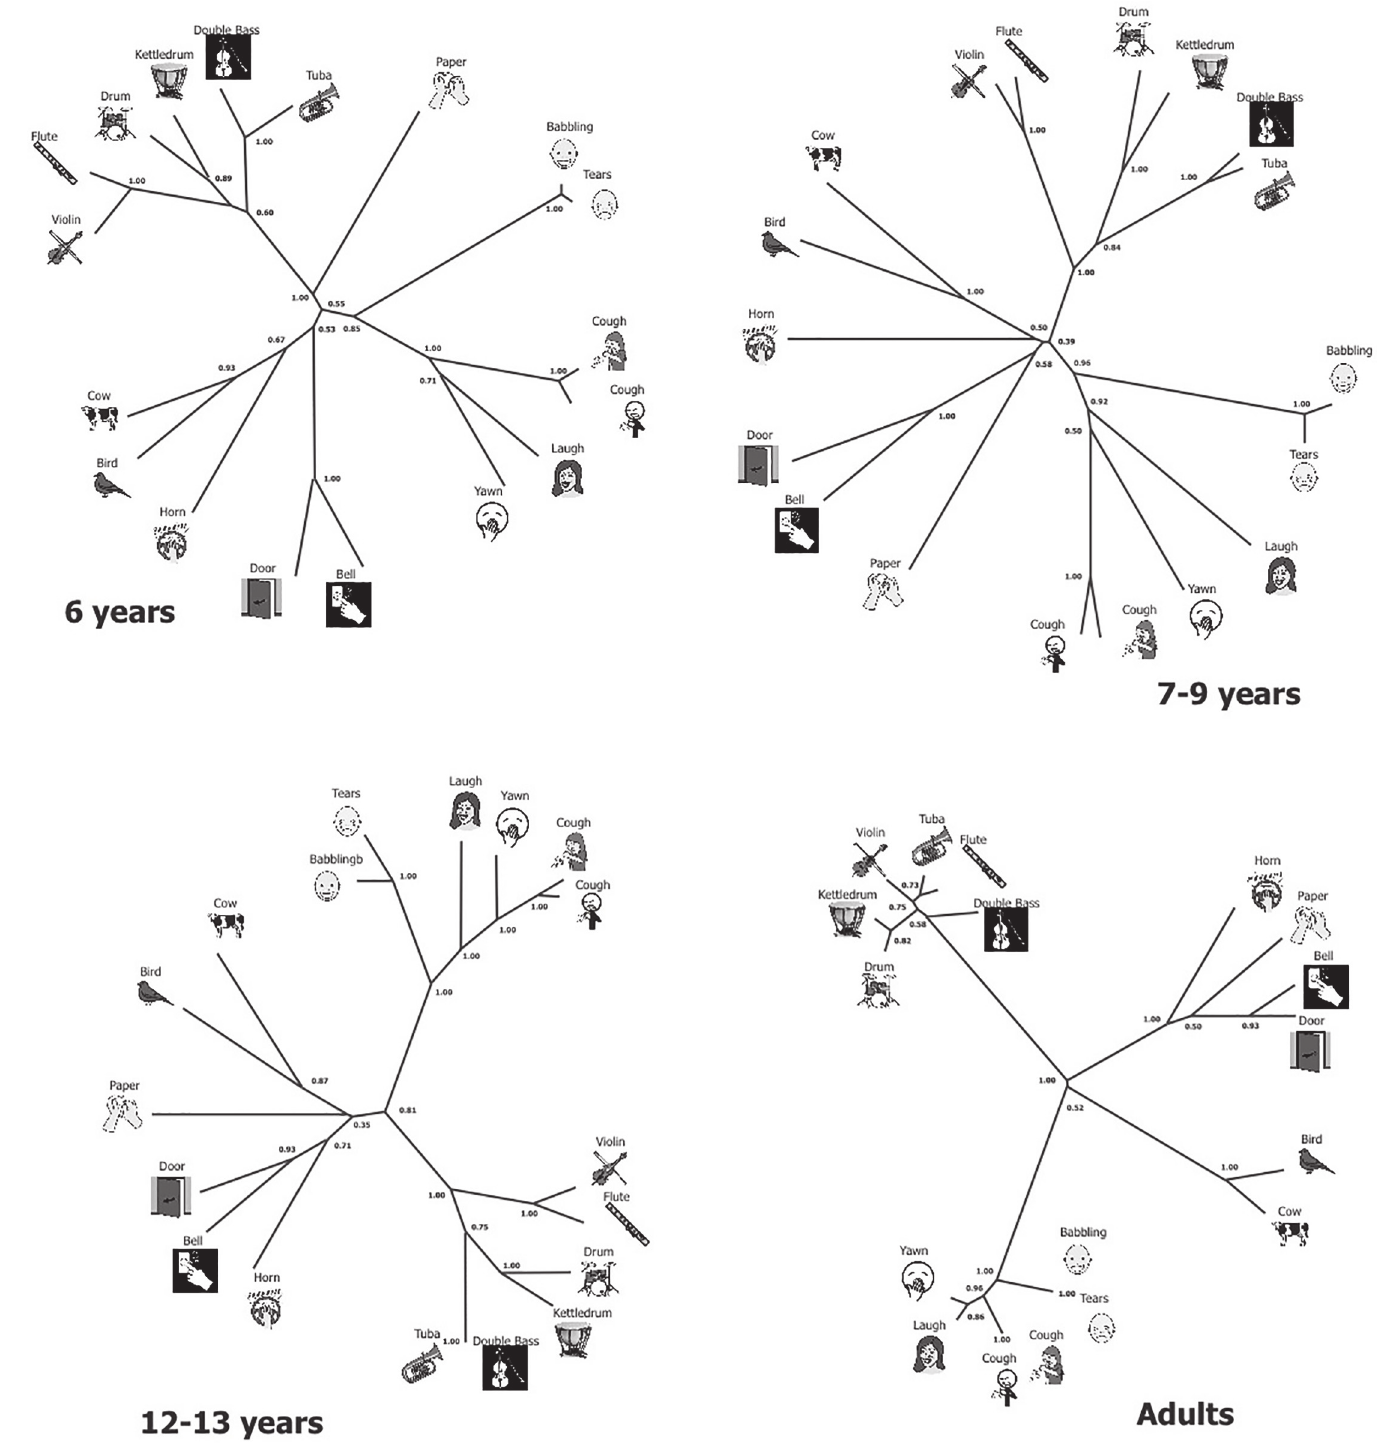
Fig 6. Additive trees showing both similarity and differences across sounds as function of age. The shorter is the line connecting two sounds, the more the sounds are judged similar.